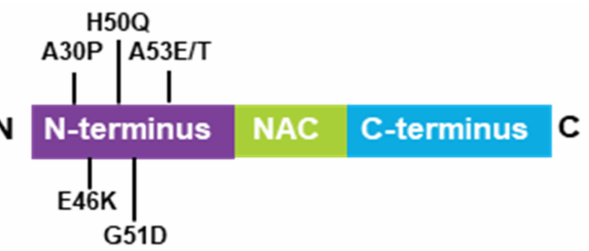
Figure 1. Schematic model of the α -synuclein structure, containing the N-terminal domain, NAC, and the C-terminal domain. Six synucleinopathy-related point mutaions described so